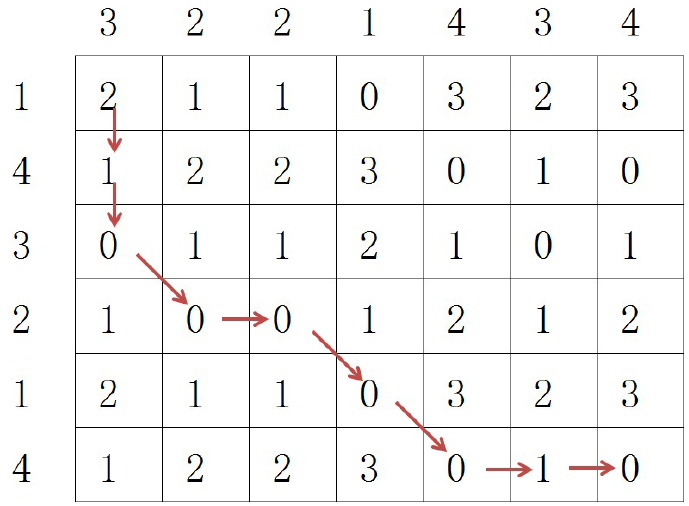
Figure 4. Example of DTW distance. The distance between each element of sequence C = {3, 2, 2, 1, 4, 1, 4, 3, 4} and sequence Q = {1, 4, 3, 2, 1, 4} is used to build a matrix, and the DTW uses a dynamic programming technique to find the minimal distance between two time series. The DTW distance is 2 + 1 + 0 + 0 + 0 + 0 + 0 + 1 + 0 = 4.